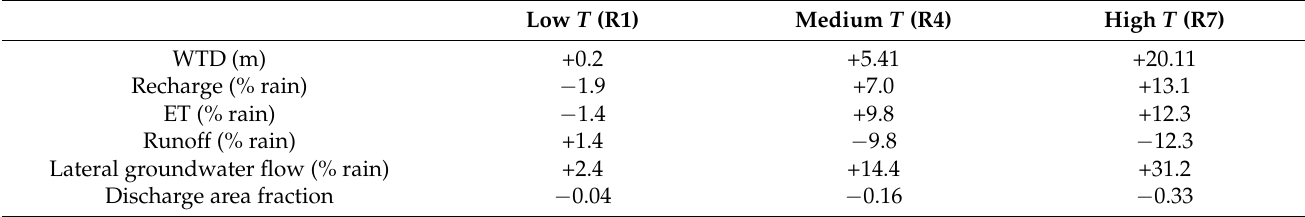
Table 5. Changes in modelled variables as grid resolution is increased for 1 ◦ to 0.05 ◦ . Changes in fluxes are expressed as a percentage of the mean